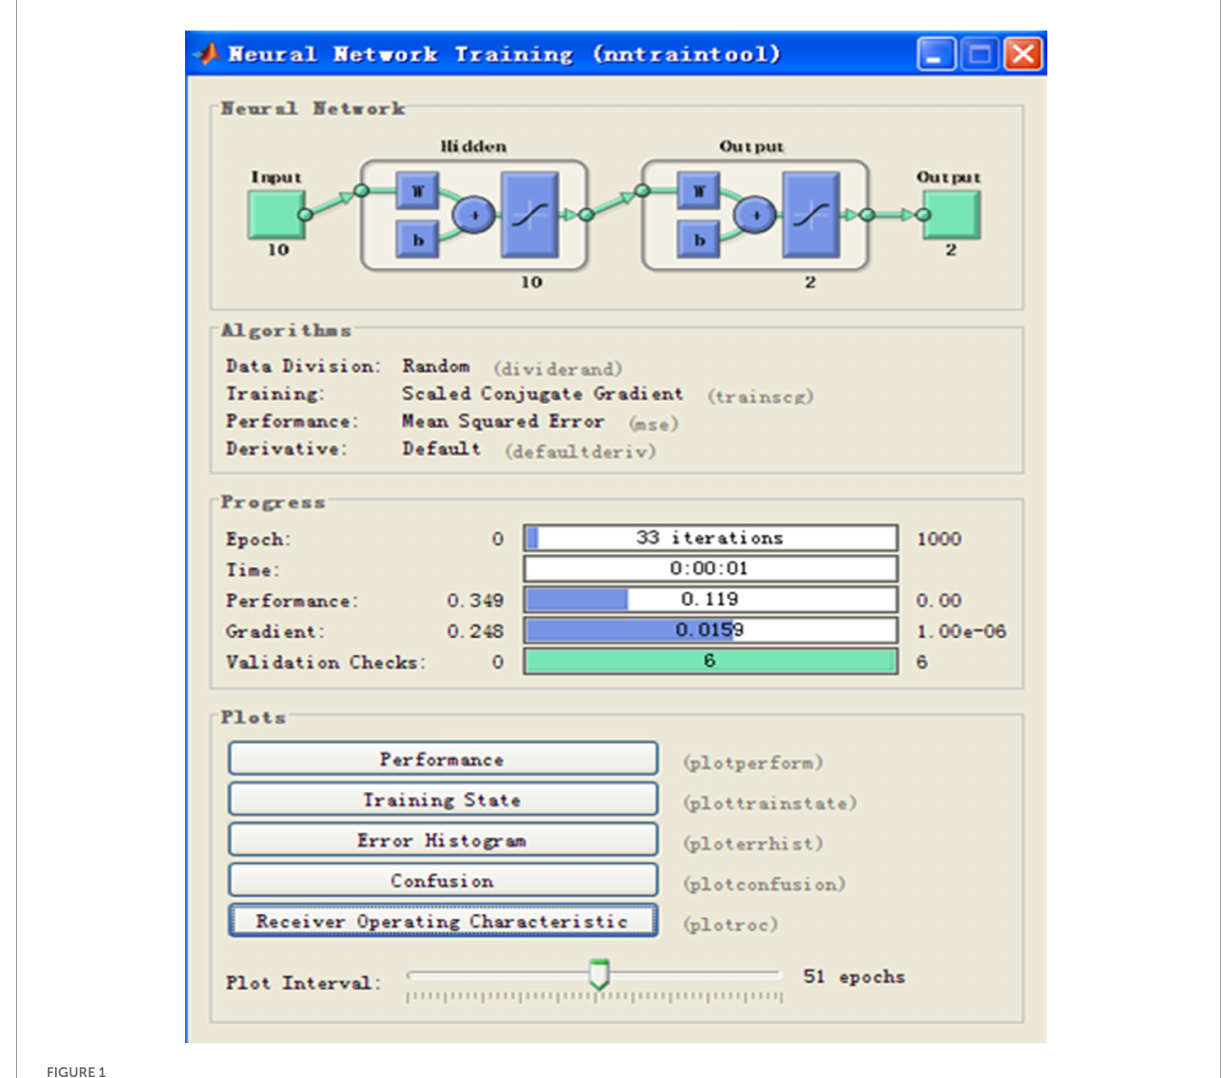
FIGURE1 Structure and the parameter settings of the back propagation (BP) neural